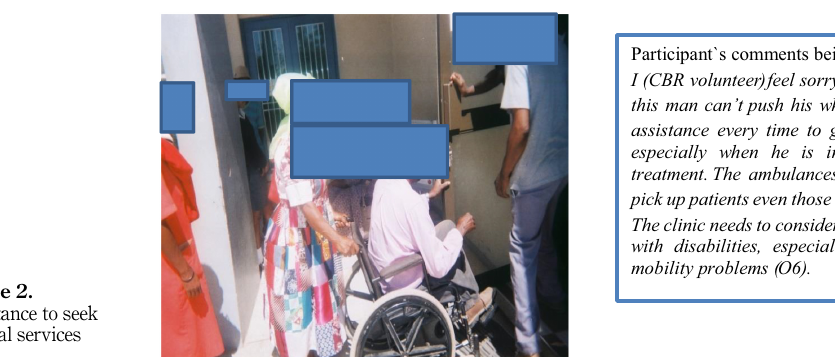
Figure 2. Assistance to